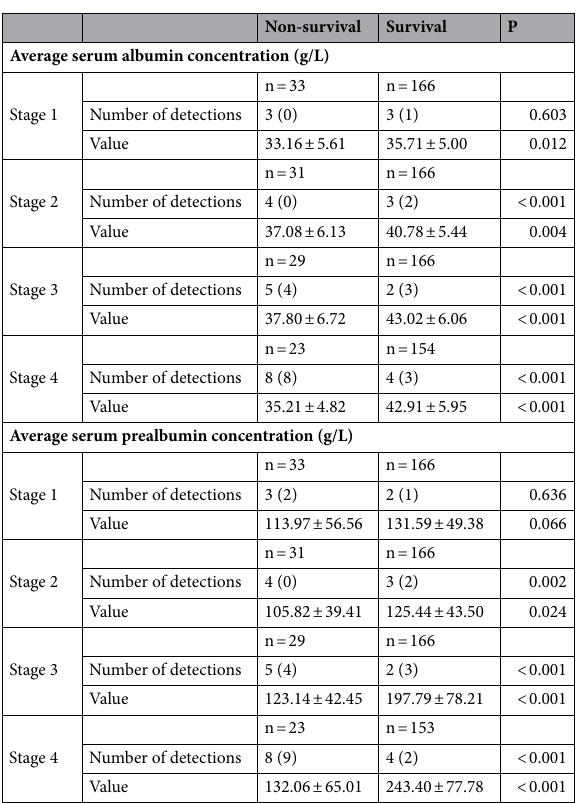
Table 2. Comparison of albumin and prealbumin in different stages of SAP patients in survival group and non-survival group. Data are presented as medians (interquartile range) or mean ± standard deviation. P values were calculated using nonparametric